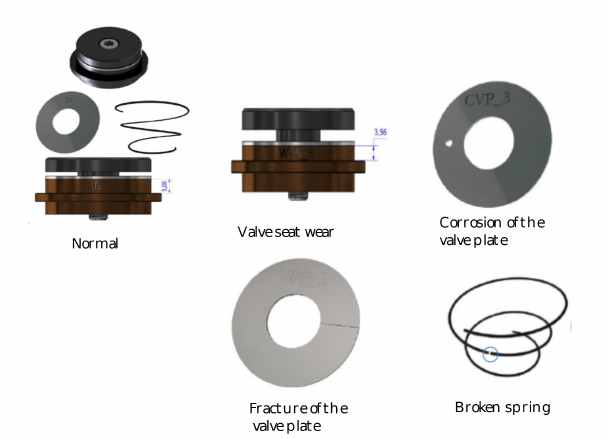
Figure 11. Different types of valve conditions.